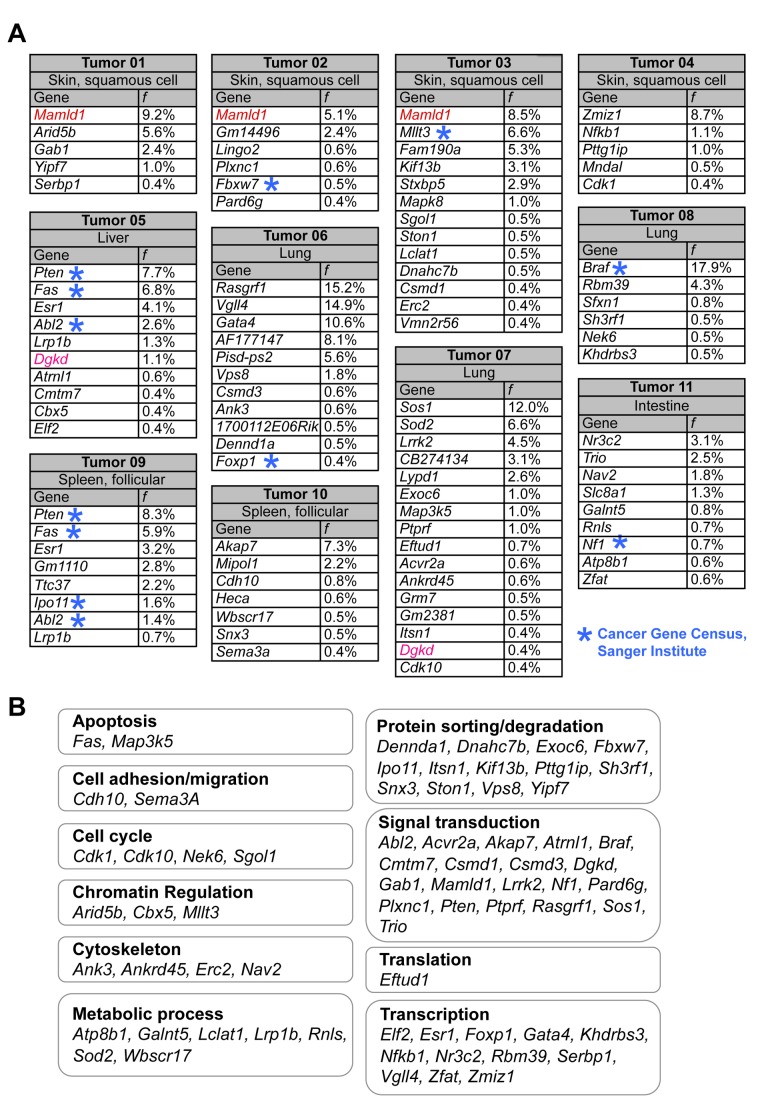
Genes associated with clonally expanded transposon insertions.A) Clonally expanded gene insertions in tumor samples, sorted by their average read frequencies (f). Three mice harbored two tumors each (tumor 01 and 08, tumor 05 and 09, and tumor 04 and 10, respectively). A blue asterisk denotes genes present in the Cancer Gene Census list, a list of 487 genes causally implicated in cancer. Mamdl1 and Dgkd were hit in independent tumor samples and are highlighted in red and pink, respectively.B) Cellular processes affected by clonally expanded gene insertions. Process categories were compiled from functional gene information at www.omim.org and www.informatics.jax.org.